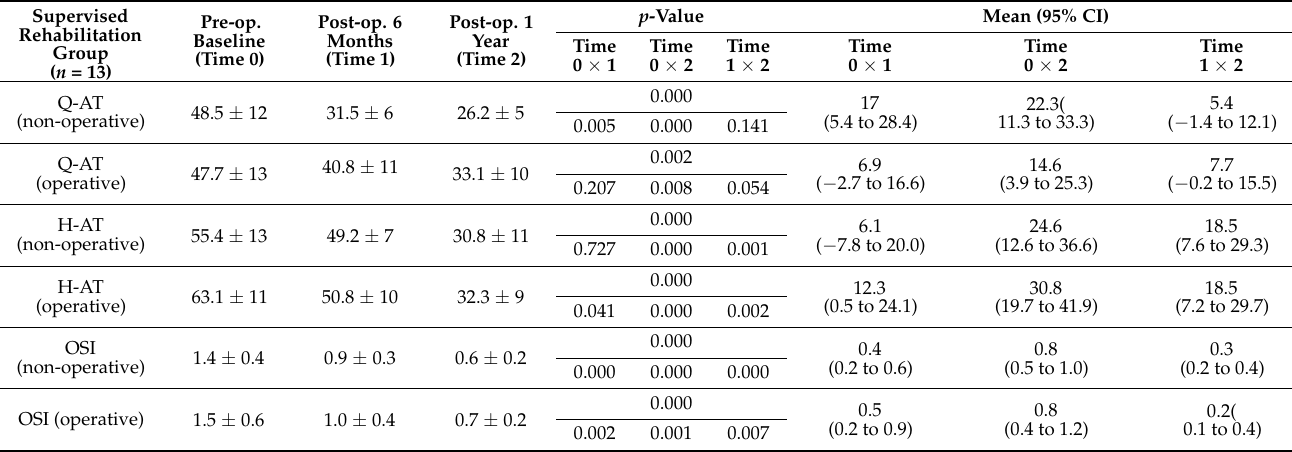
Table 4. Serial changes in muscle ratio and strength of quadriceps and hamstring of enrolled subjects in the home-based rehabilitation group.